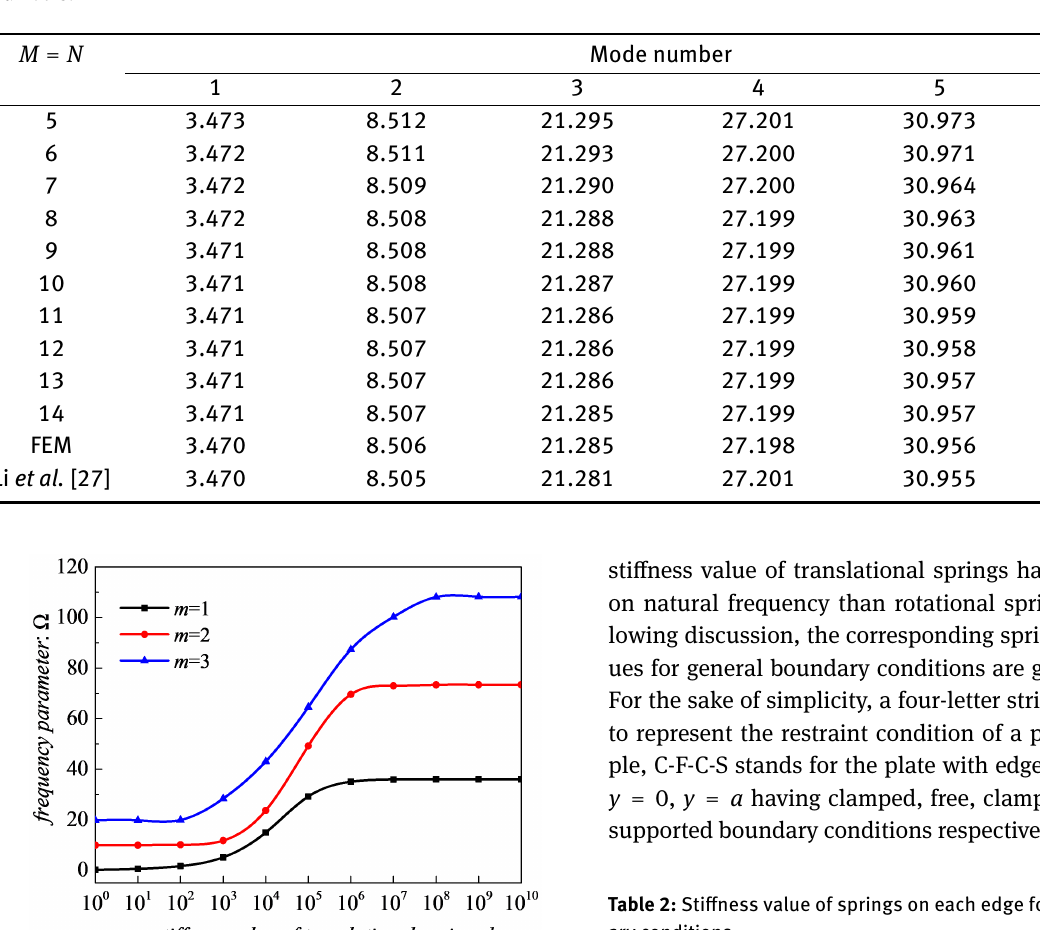
Table 1: Comparison and convergence of the first six frequency parameters Ω for a C-F-F-F rectangular thin plate with different truncation